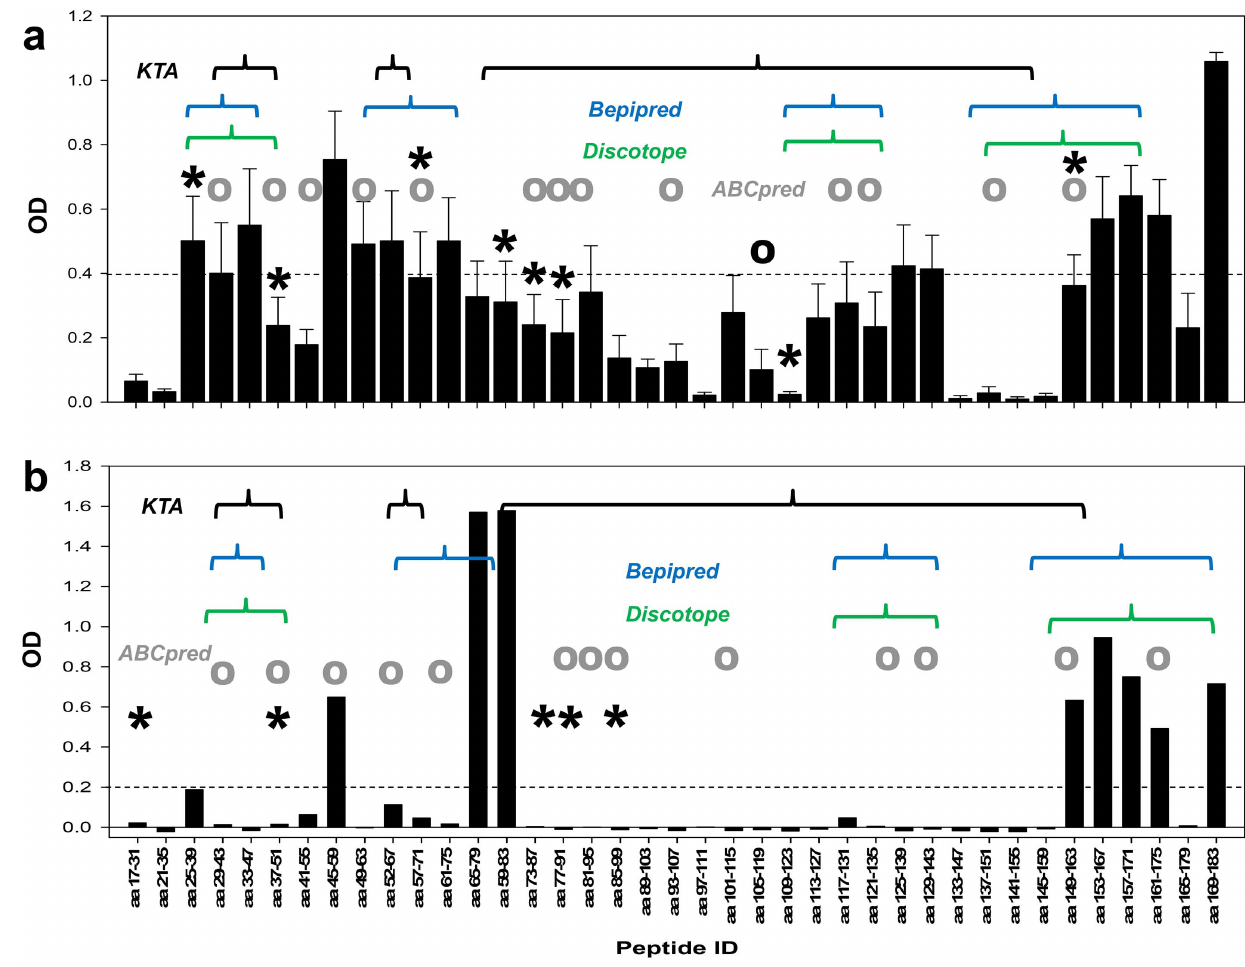
Figure 1. Comparison of specificity of invivo immune responses with insilico predictions using various algorithms. Individual rabbit (Panel A, n=8 animals) or mouse (Panel B, n=10 animals) immune sera were analyzed by ELISA and reported as OD values (bar graph). X-axis indicates the peptide ID and span; Y-axis indicates the OD value of the ELISA after subtracting the background measured for pre-immune sera. Horizontal line indicates threshold OD as described in Materials and Methods. Brackets indicate the segments of the protein predicted to be immunogenic by the KTApred (black), the Bepipred (blue) or the Discotope (green) algorithms. Open circles (grey) above individual bars identify peptides predicted by the ABCpred prediction tool. Asterisks above individual bars indicate positive responses detected by MALDI-TOF MS analysis. The MALDI-TOF data are the mean of three independent experiments using pooled immune sera. Responses from pooled pre-immunes were subtracted.